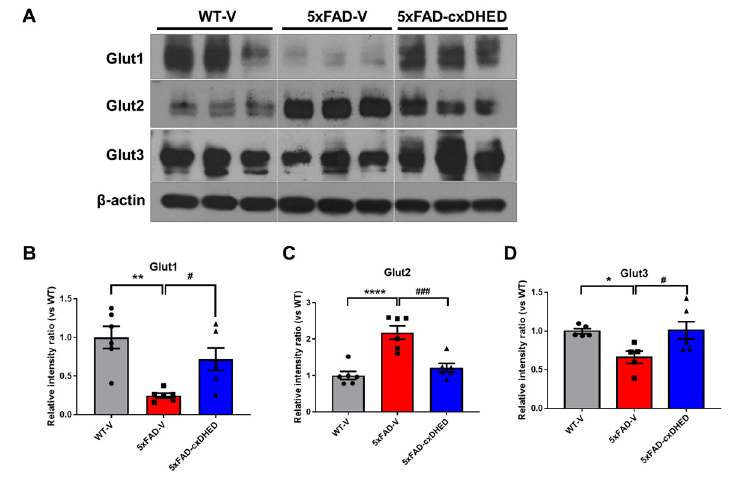
Figure 4. cx-DHED rescued the abnormal expressions of glucose transporters in the brain of 5xFAD mice. ( A ) Protein expression levels of glucose transporters (GLUT) in the cortex of mice. ( B ) GLUT1 (WT-V; n = 6, 5xFAD; n = 6, 5xFAD-cx-DHED; n = 6), ( C ) GLUT2 (WT-V; n = 6, 5xFAD; n = 6, 5xFAD- cx-DHED; n = 6), and ( D ) GLUT3 (WT-V; n = 5, 5xFAD; n = 5, 5xFAD-cx-DHED; n = 6) expression levels were normalized to β -actin. Values are expressed as the mean ± standard error of the mean. * p < 0.05, ** p < 0.01, and **** p < 0.0001 vs. WT-V group; # p < 0.05 and ### p < 0.001 vs. the 5xFAD-V group. Statistical analysis between the three groups was performed using the one-way analysis of variance, followed by Turkey’s post hoc test.